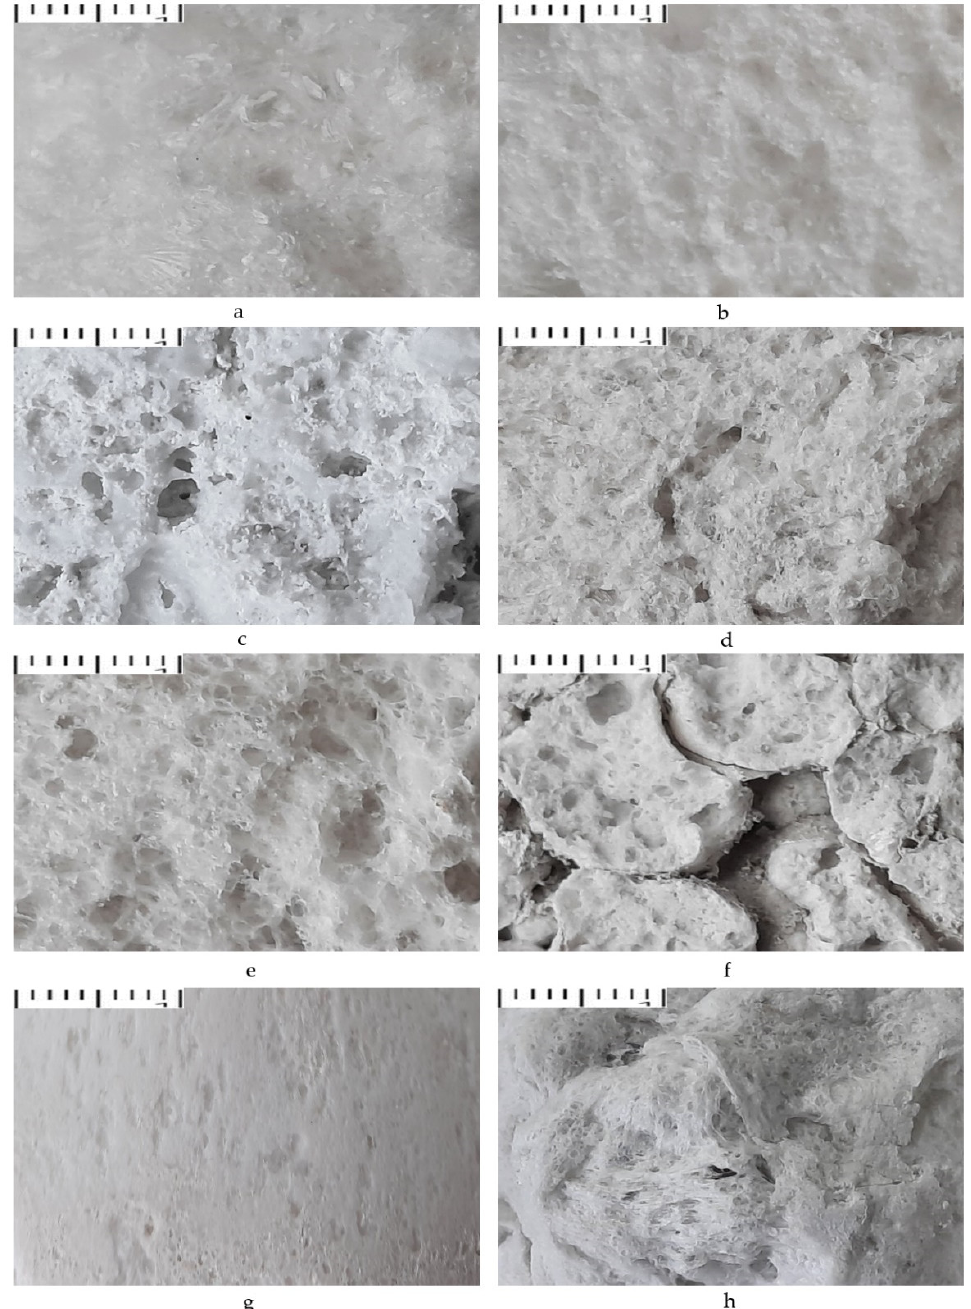
Figure 2. The porous structure of the composite material obtained under: ( a ) microwave exposure (power 500 W); ( b ) microwave exposure (power 650 W); ( c ) convective heating (T = 200 °C); ( d ) convective heating (Т = 300 °С); ( e ) convective heating (Т = 500 °С); ( f ) convective heating (Т = 600 °С); ( g ) the surface of samples obtained by microwave heating (power 650W); ( h ) the surface of samples obtained by convective heating at T = 300–500 °C (magnification × 10 for all samples).